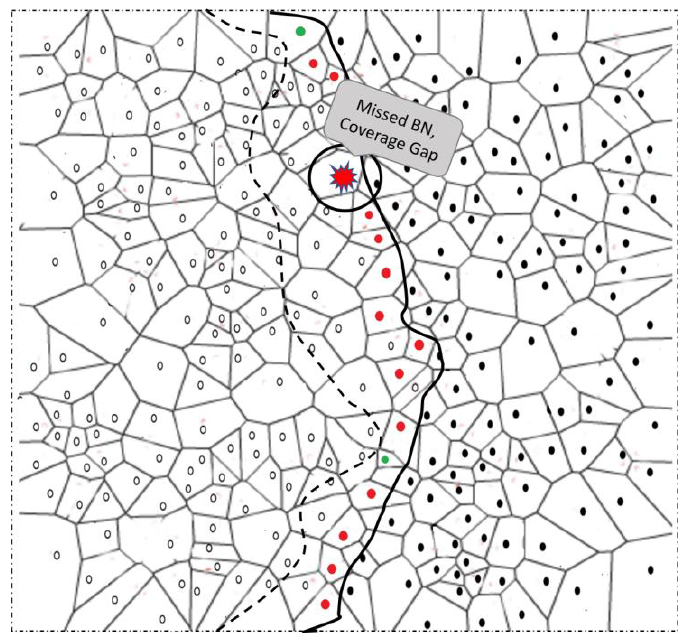
Figure 6. Example of a failing node and its effect on BN selection.